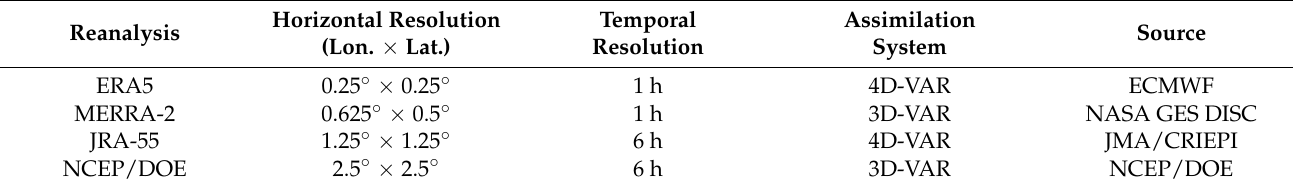
Table 1. Summary of four reanalysis products used in this